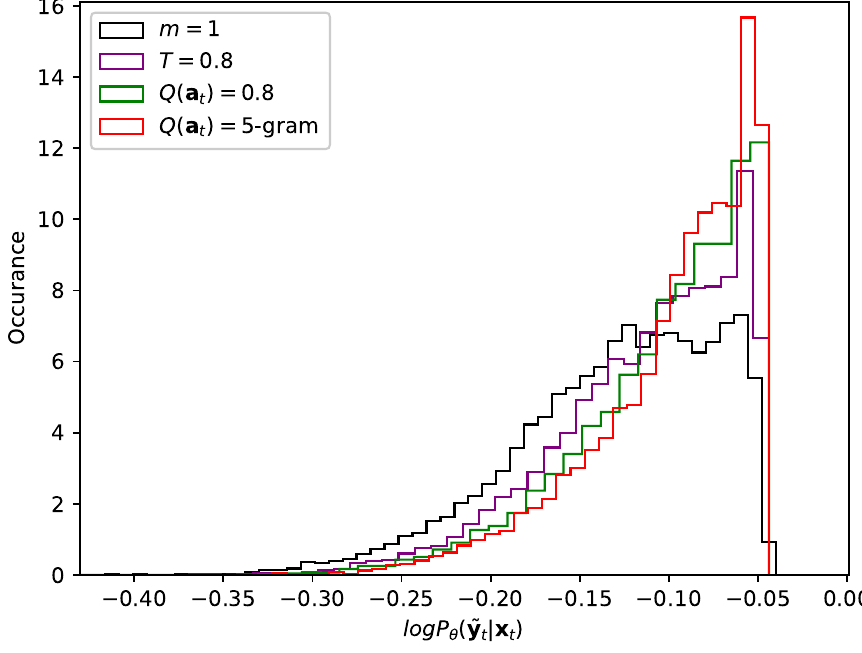
Figure 4. Histogram of logP θ ( ˜ y | x ) for unlabeled